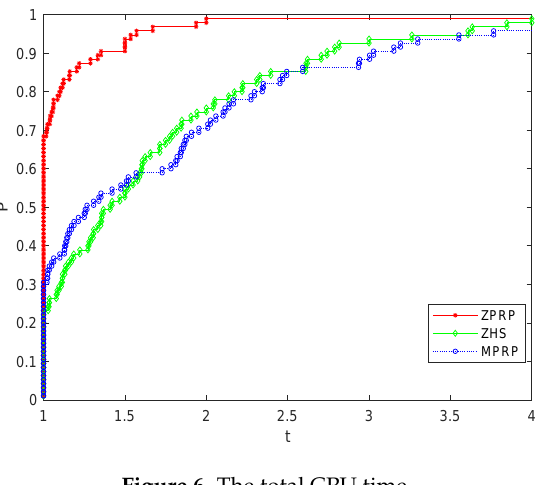
Figure 6. The total CPU